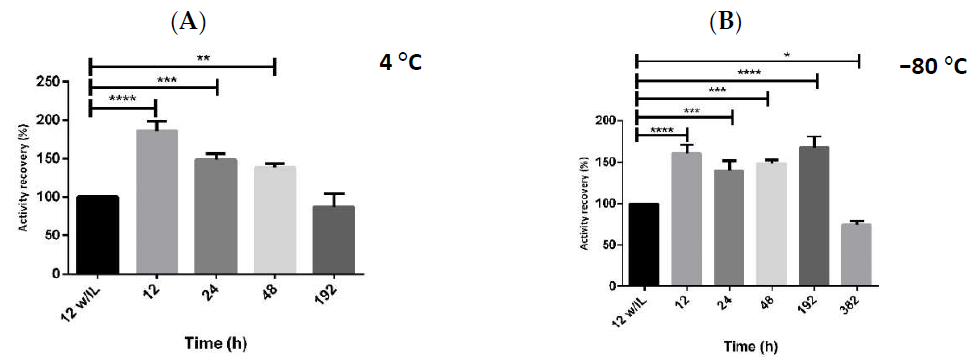
Figure 2. Graphical representation of the activity recovery of the protein hMBCOMT lysate in comparison to hMBCOMT in contact with 10 mM of [Ch][DHP] when storage at ( A ) 4 and ( B ) − 80 ◦ C. ( p -value * <0.05; ** <0.01; *** <0.001; **** <0.0001).